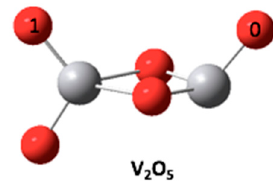
Figure 6. V 2 O 5 and Hg reaction model.